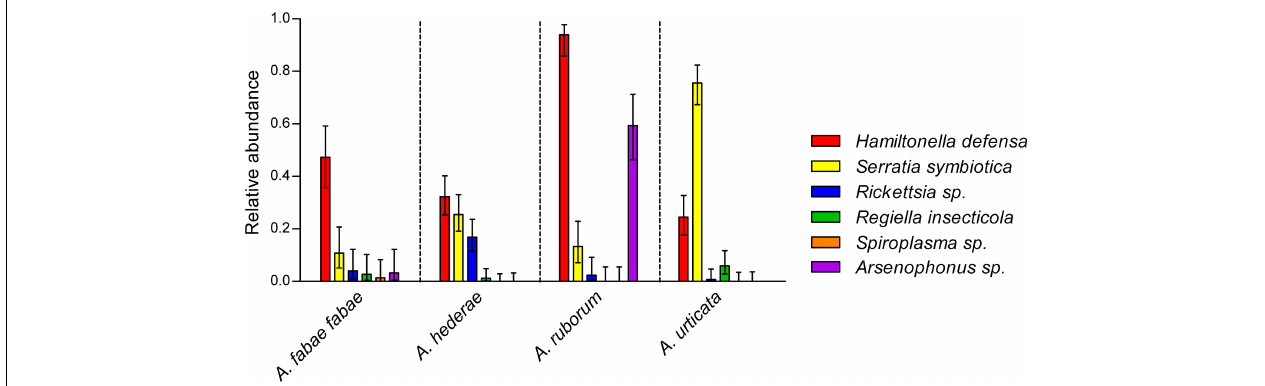
FIGURE 2 | Symbiont relative abundances in wild A. fabae fabae ( N = 74), A. hederae ( N = 161), A. ruborum ( N = 83), and A. urticata ( N = 135). Bars show mean frequencies and errors are 95% confidence intervals. Non-overlapping confidence intervals represent significant differences at least to the 0.05